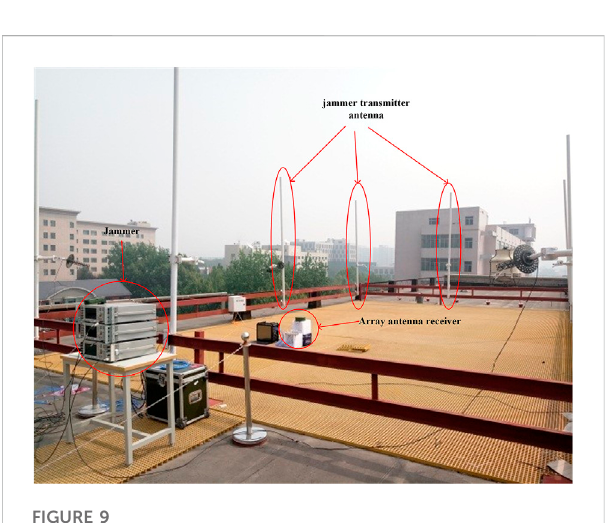
FIGURE 9 Experimental scene diagram.